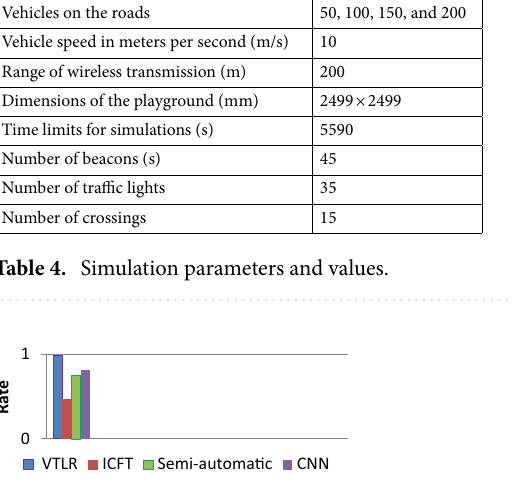
Figure 5. A recognition success rate comparison between VTLR, ICFT, Semi-Automatic, and CNN traffic light detection.